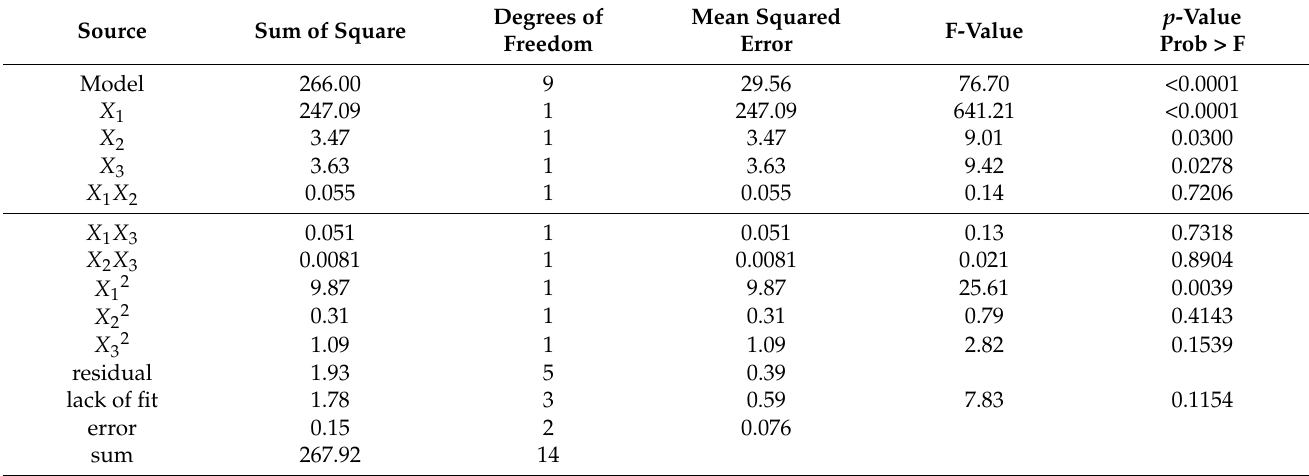
Table 8. Variance analysis of the open water